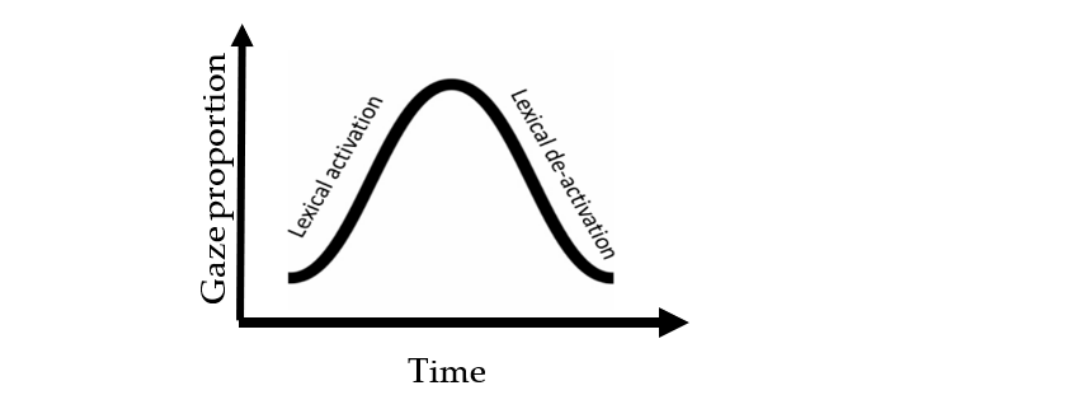
Figure 1. An illustration of the overall pattern of lexical processing in an ongoing sentence that involves an activation and de-activation phase. Activation is represented by increase in gaze proportion toward the heard item in the sentence while de-activation is represented by reduction in gaze proportion over time.